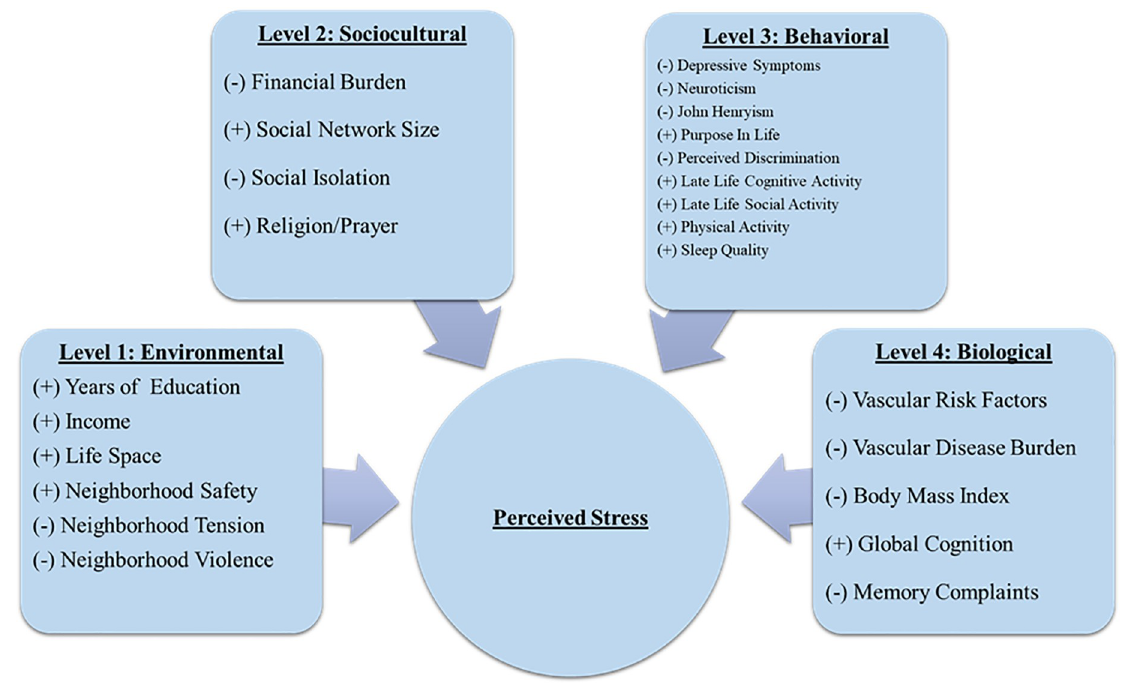
Fig 1. Hypothesized relationships between correlates � within each level and perceived stress. � (+) Indicates a positive correlate that we hypothesize as associated with lower levels of perceived stress. � (-) Indicates a negative correlate that we hypothesize as associated with higher levels of perceived